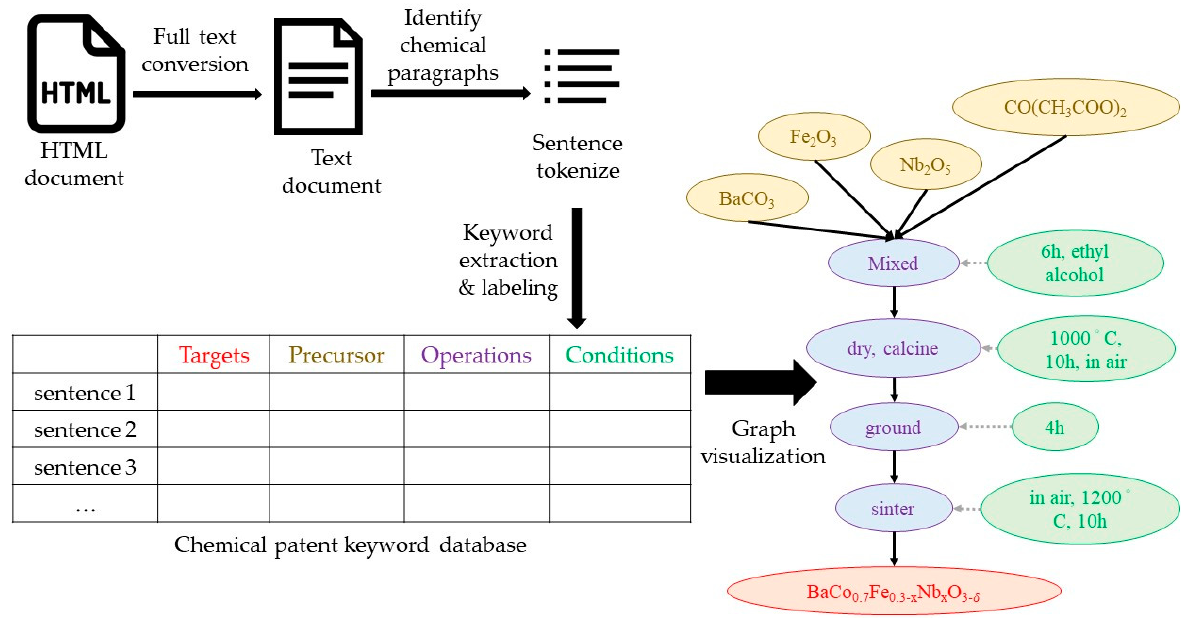
Figure 4. Random Layout and Spring Layout.